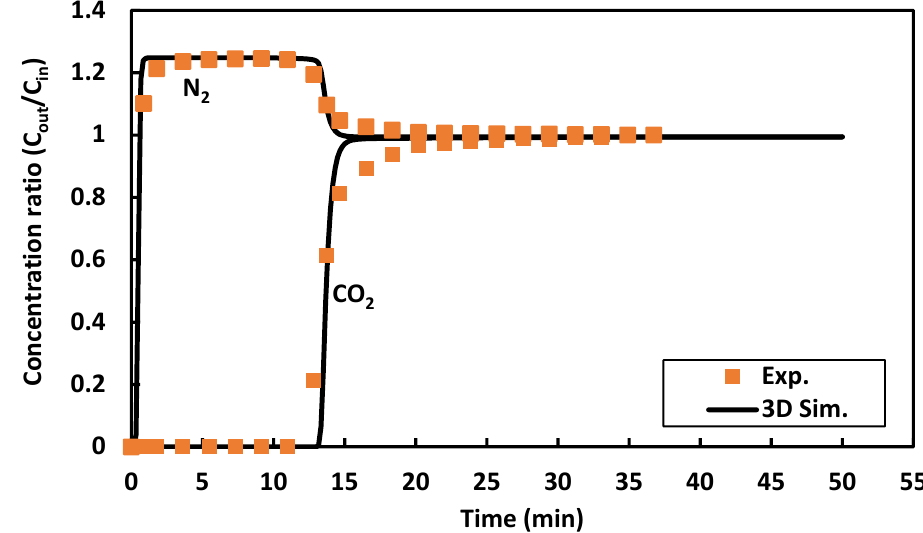
Figure 2. Breakthrough concentration ratio of CO2 and N2 at the bed outlet during the adsorption process using Mg-MOF-74 to compare the 3D simulation with the experimental data (at bed porosity = 0.674, particle size = 0.2 mm, bed length = 7 cm, bed diameter = 0.4 cm) [23]. Mg-MOF-74 is synthesized and characterized in the previous study [22].